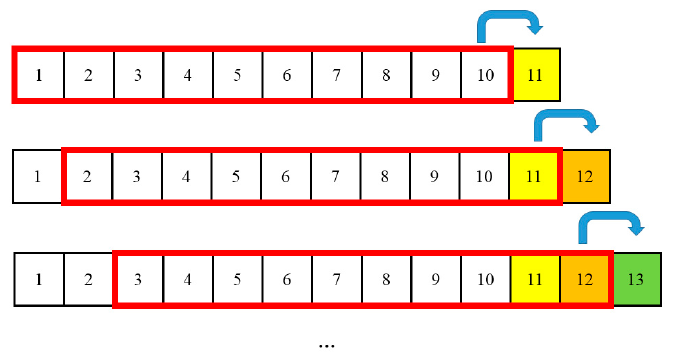
Figure 3. Flow-process diagram for usage of datasets.